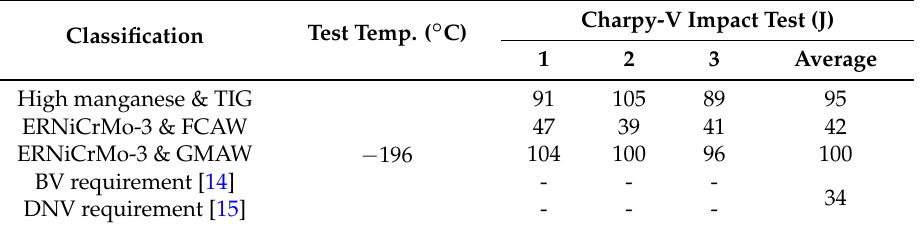
Table 5. Charpy-V impact test results of the weldments